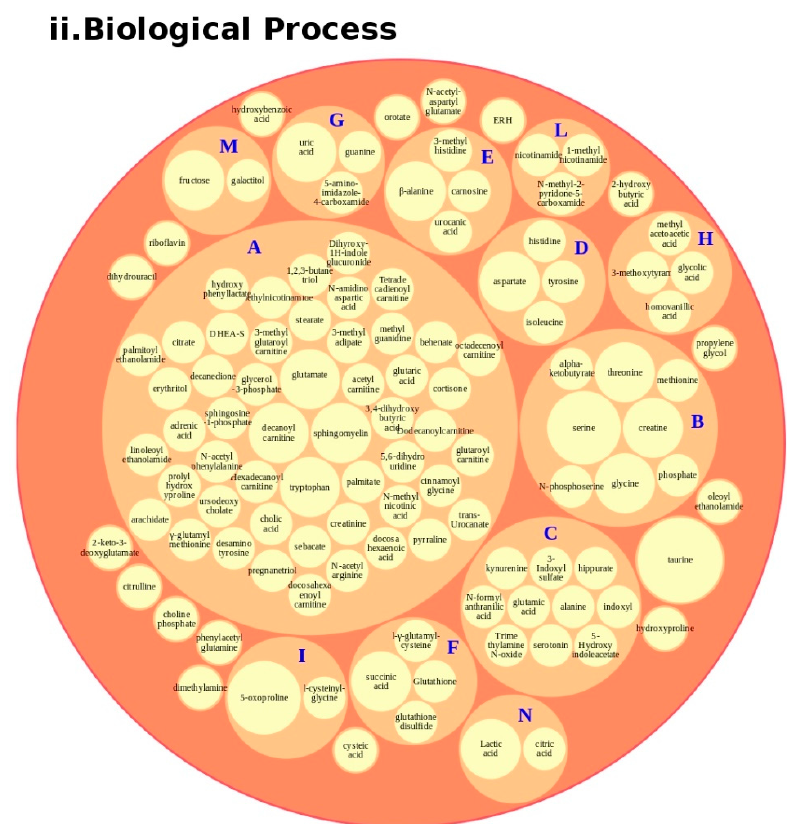
Figure 5. Metabolites analysis as a tool for the decision support system (DSS). In box ( i ), we grouped the metabolites highlighted in Table 2 and Table S1 according to the matrix in which the metabolites were studied, such as blood (orange), blood and urine (lawn green), brain (red), dried blood (brown), urine (pink), and brain, urine and blood (lilac). The size of the bubbles indicates the number of times the metabolites were found in that matrix in the di ff erent studies taken into consideration. We analyzed the data for the biological process (box ( ii ) and clustered the metabolites. Legend code: A: Lipid